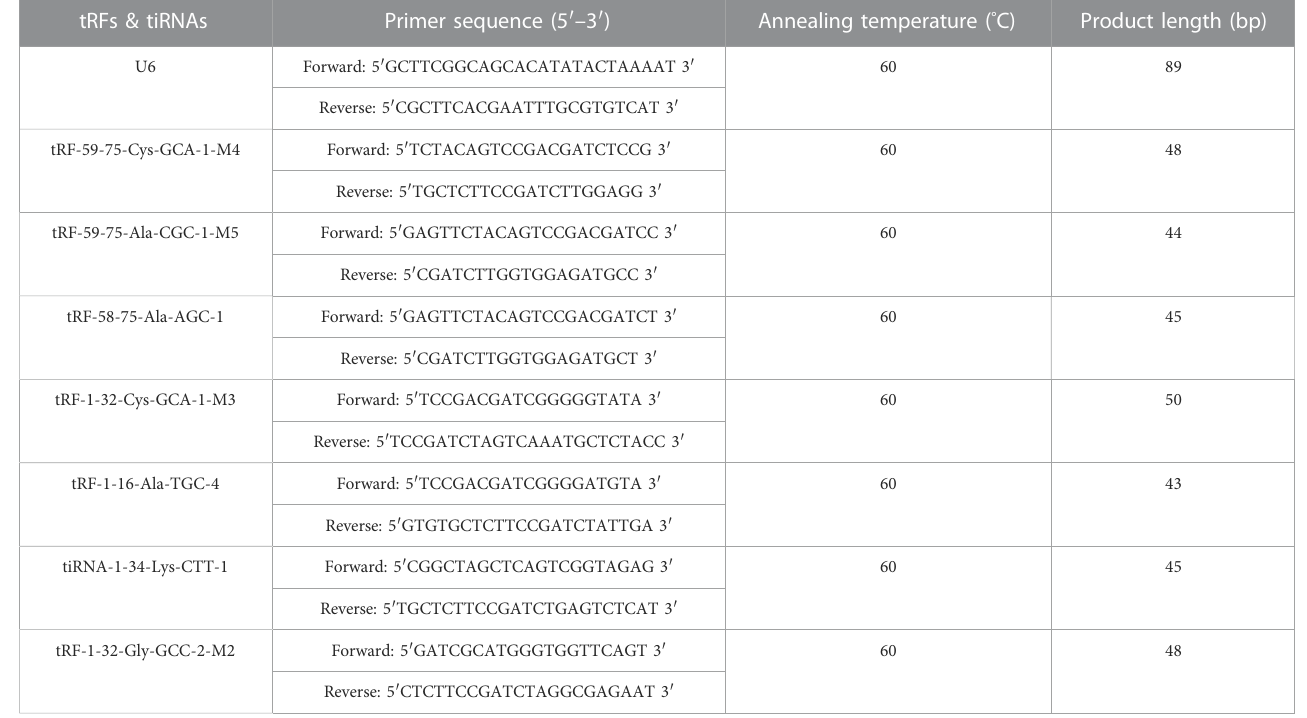
TABLE 1 Primers for ampli fi cation of the tRF transcripts. tRFs & tiRNAs Primer sequence (5 ′ – 3 ′